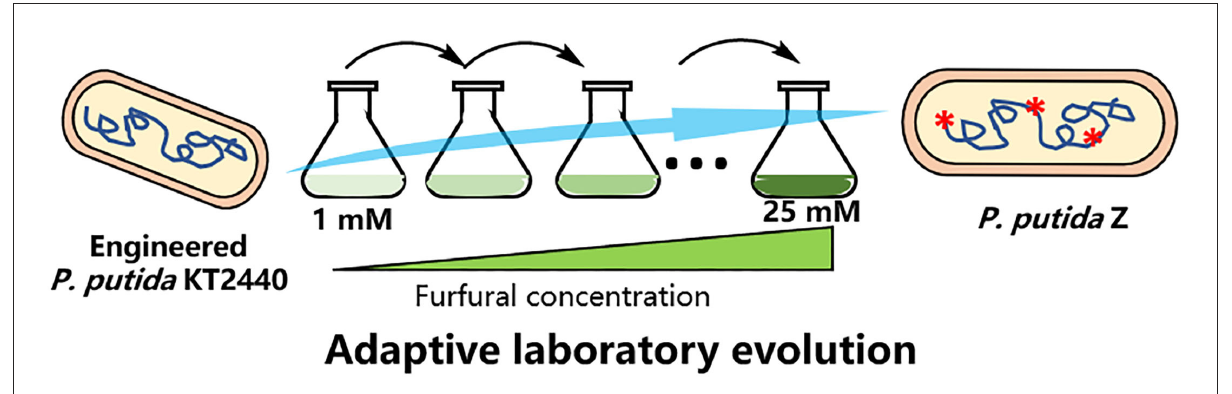
FIGURE1 Diagram of adaptive laboratory evolution used in this